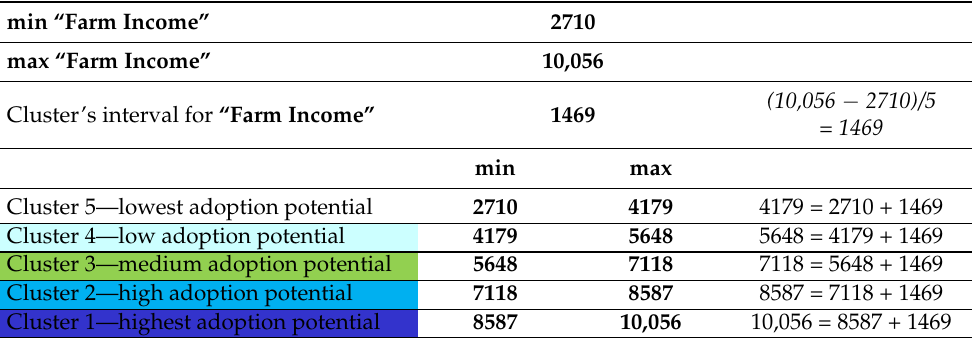
Table 9. Calculations for the “cluster interval” for variable “Farm Income” (Agricultural output— Market Value) .